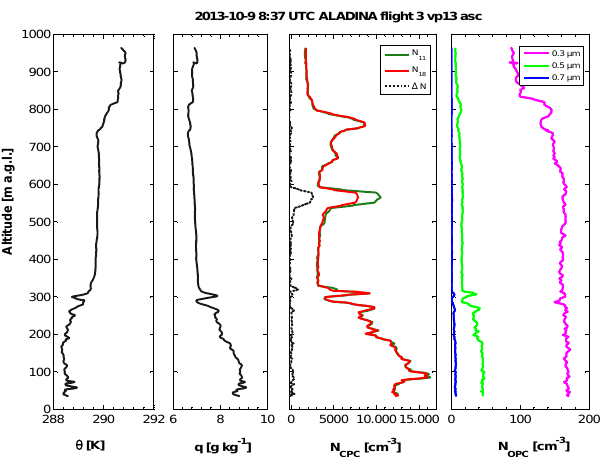
Figure 15. Same as Fig. 15 but during flight 3 (ascent) in Melpitz on 9 October 2013 at 08:37UTC.